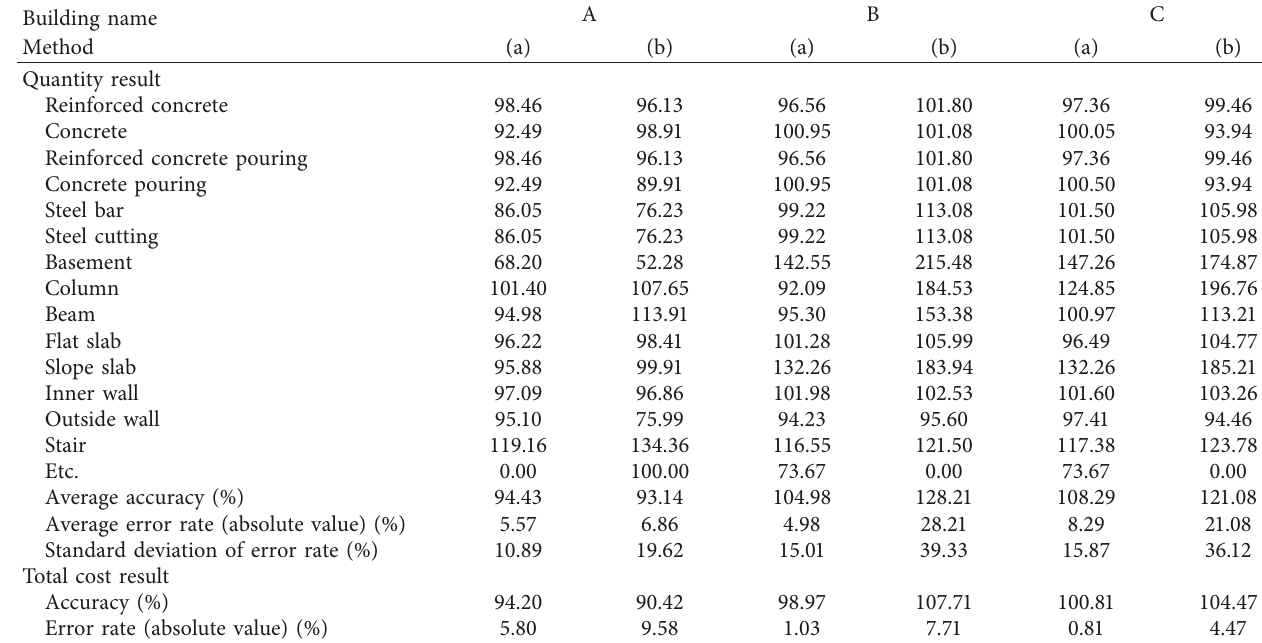
Table 6: Validation